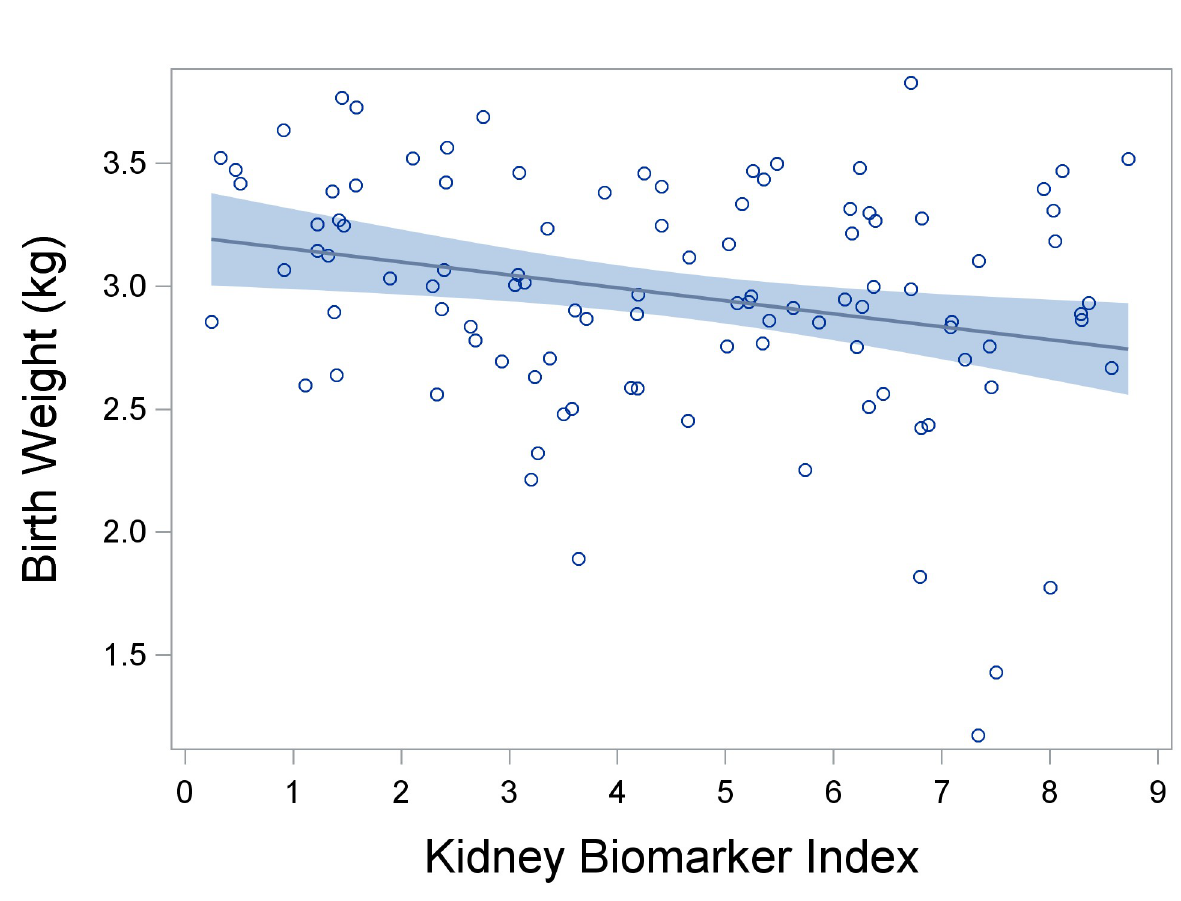
Fig 3. The association between the kidney biomarker index and birth weight (in kilograms) (n = 103). A decile increase in the kidney biomarker index was associated with 0.1-kg (59-gram) lower birth weights ( β = -0.06, 95% CI: -0.10, -0.02). The dark blue line is a linear regression with the 95% confidence interval of the mean shown in lighter blue; the circles represent the values of the birth weight. Plotted birth weight values are residuals accounting for child sex, age, BMI, indoor smoking, and urinary creatinine.